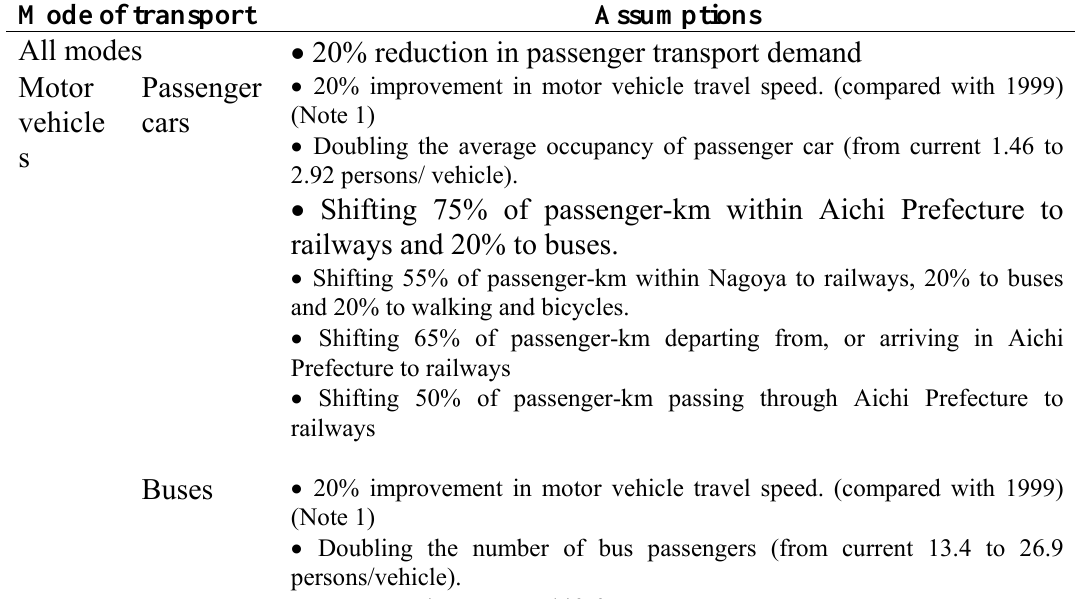
Table 15. Assumptions on transport activities in EST2 Scenario (Aichi Prefecture) Mode of